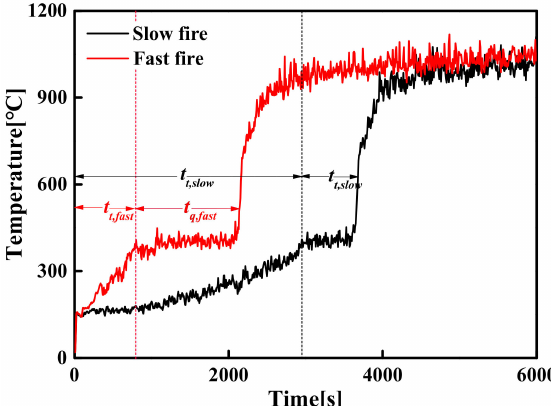
Figure 26. Comparison of temperature evolution process under different fire growth